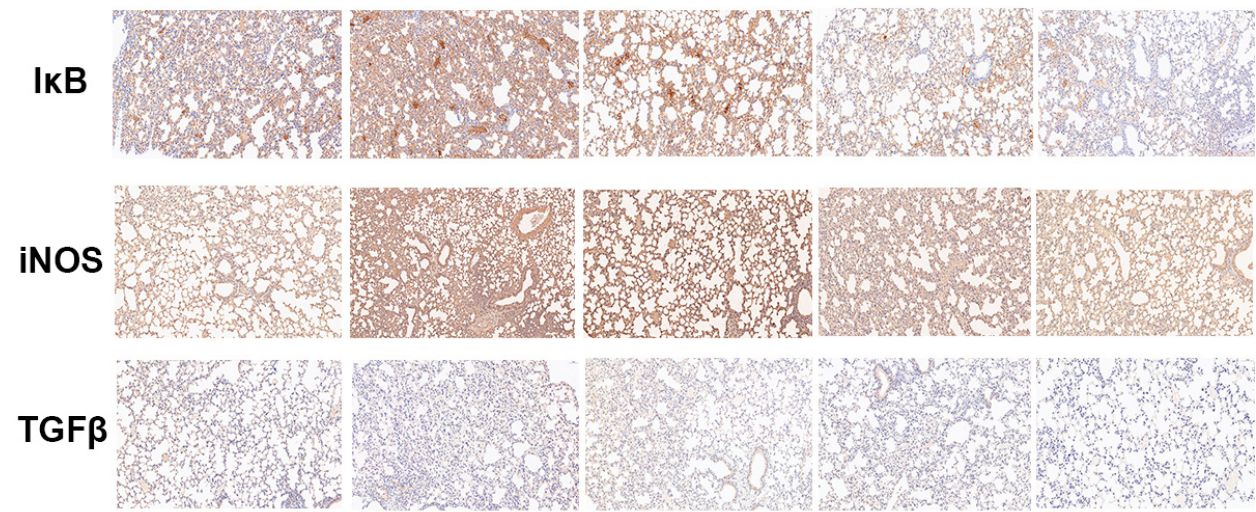
Figure 7. Effect of baicalin on the protein expression level of I κ B, TGF- β 1, and iNOS in LPS- induced ALI mice. LPS + baicalin group mice ( n = 6 per group) were given an intraperitoneal injection of baicalin (25, 50, and 100 mg/kg) 1 h prior to LPS administration. After 12 h, the blood was collected. The resolution was ×200.